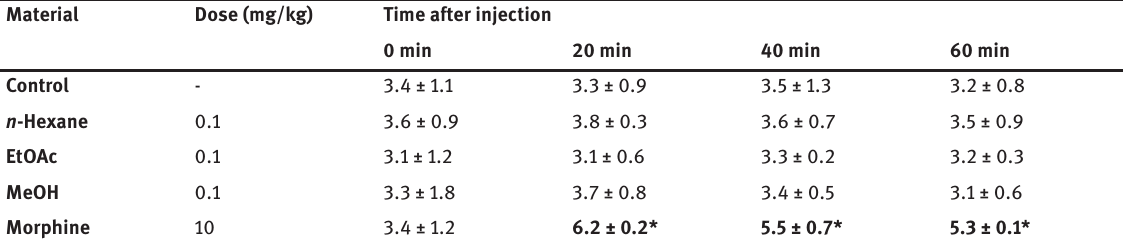
Table 4: Effects of the extracts on tail flick test. Material